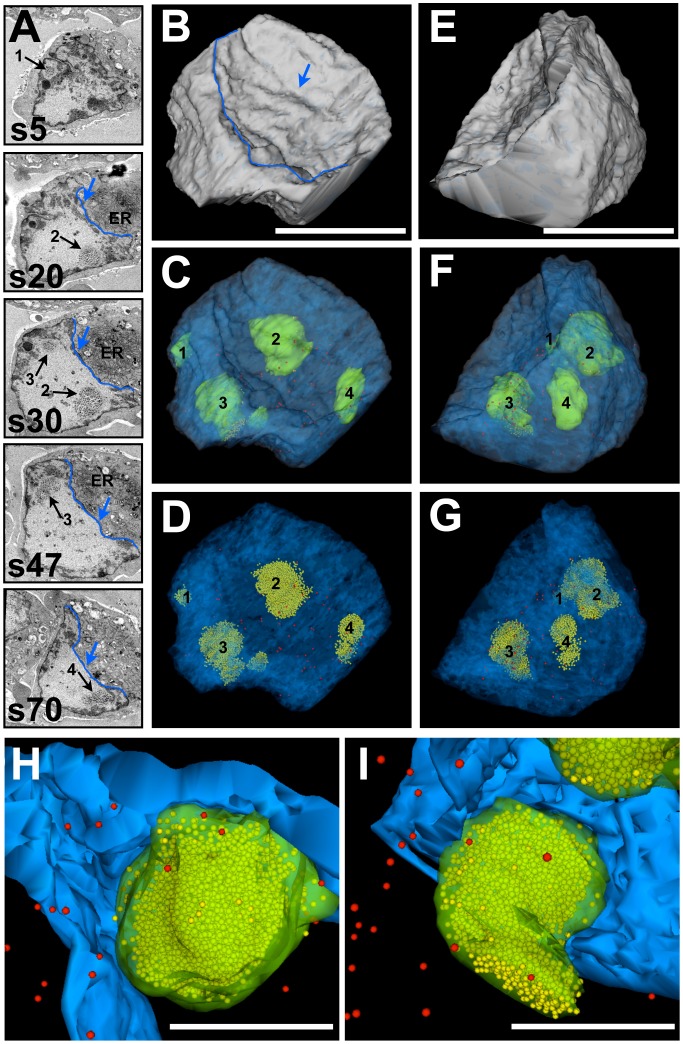
Large volume-reconstruction of a VZV infected cell nucleus with four PML cages.Melanoma cells that express doxycycline-induced PML IV were infected with VZV for 48 h and processed for BSE-SEM imaging. (A) Five representative BSE-SEM images (s5, s20, s30, s47, s70) from a series of 82 consecutive sections through a VZV nucleus with four PML cages (1–4, black arrows) with sequestered VZV capsids. A valley-like indentation of the nucleus (blue outline and arrow) and the endoplasmic reticulum (ER) are marked. See also Video S6. (B–D and E–G, respectively) show 3D models of the nucleus in two angles (100 degrees rotation to the left). (B and E) Shape of the nucleus based on tracing its outer boundary (grey). (C and F) The shape of the nucleus (transparent grey) is overlaid with the dense heterochromatin (transparent blue). PML cages 1–4 (solid green) and VZV capsids that escaped sequestration (red spheres) are visible in the interior of the nucleus. (D and G) Same view as above, but the nuclear envelope and the PML domains are completely transparent. This reveals the location of all VZV capsids (5,597) identified in this nucleus; red spheres represent free capsids (70) and yellow spheres represent sequestered capsids (5,527). Scale bars are 5 µm. See also Video S7. (H and I) 3D models of PML cages (transparent green) from the same nucleus at higher magnification that reveal the dense packaging of capsids (yellow) and the close association of PML cages with the electron dense heterochromatin (blue). Red spheres represent free capsids. Scale bars are 2 µm. See also Video S8.